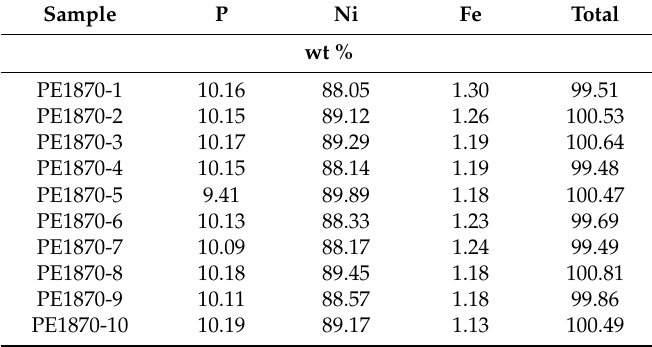
Table A5. Representative electron microprobe analyses (wt %, at.%, and apfu) of the NiFeP compound from chromitites of